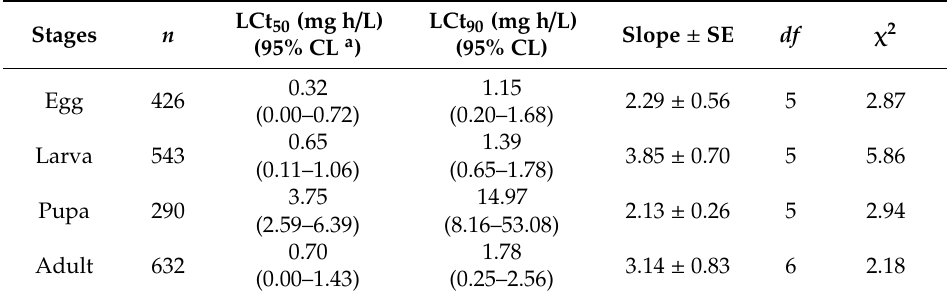
a CL denotes the confidence